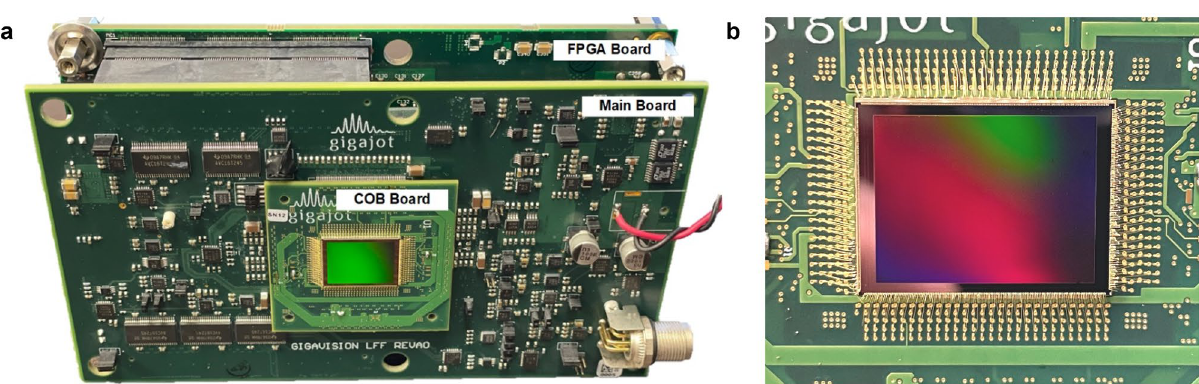
Figure 3. ( a ) The test system developed for the evaluation of the sensor that includes a main PCB, a COB PCB, and a FPGA PCB. ( b ) The photo of the sensor on the COB board shot from the backside of the pixel array (illumination